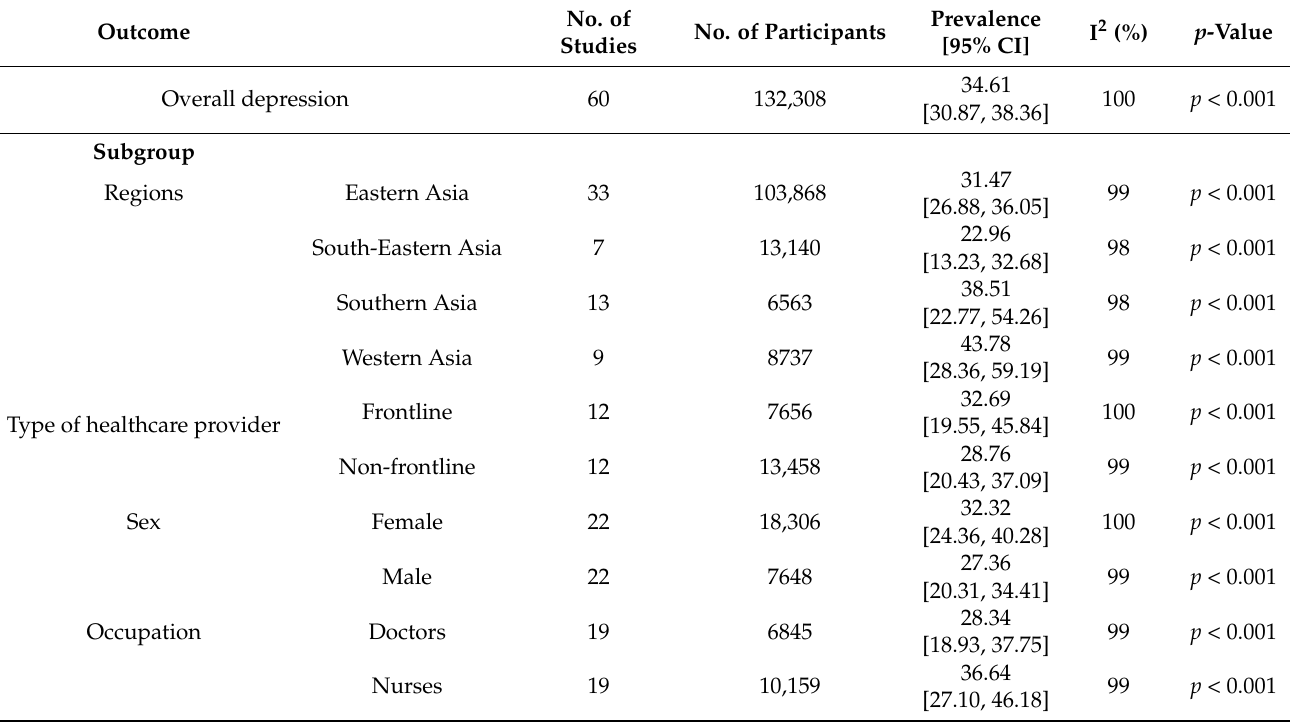
Table 2. Pooled prevalence of depression and subgroup